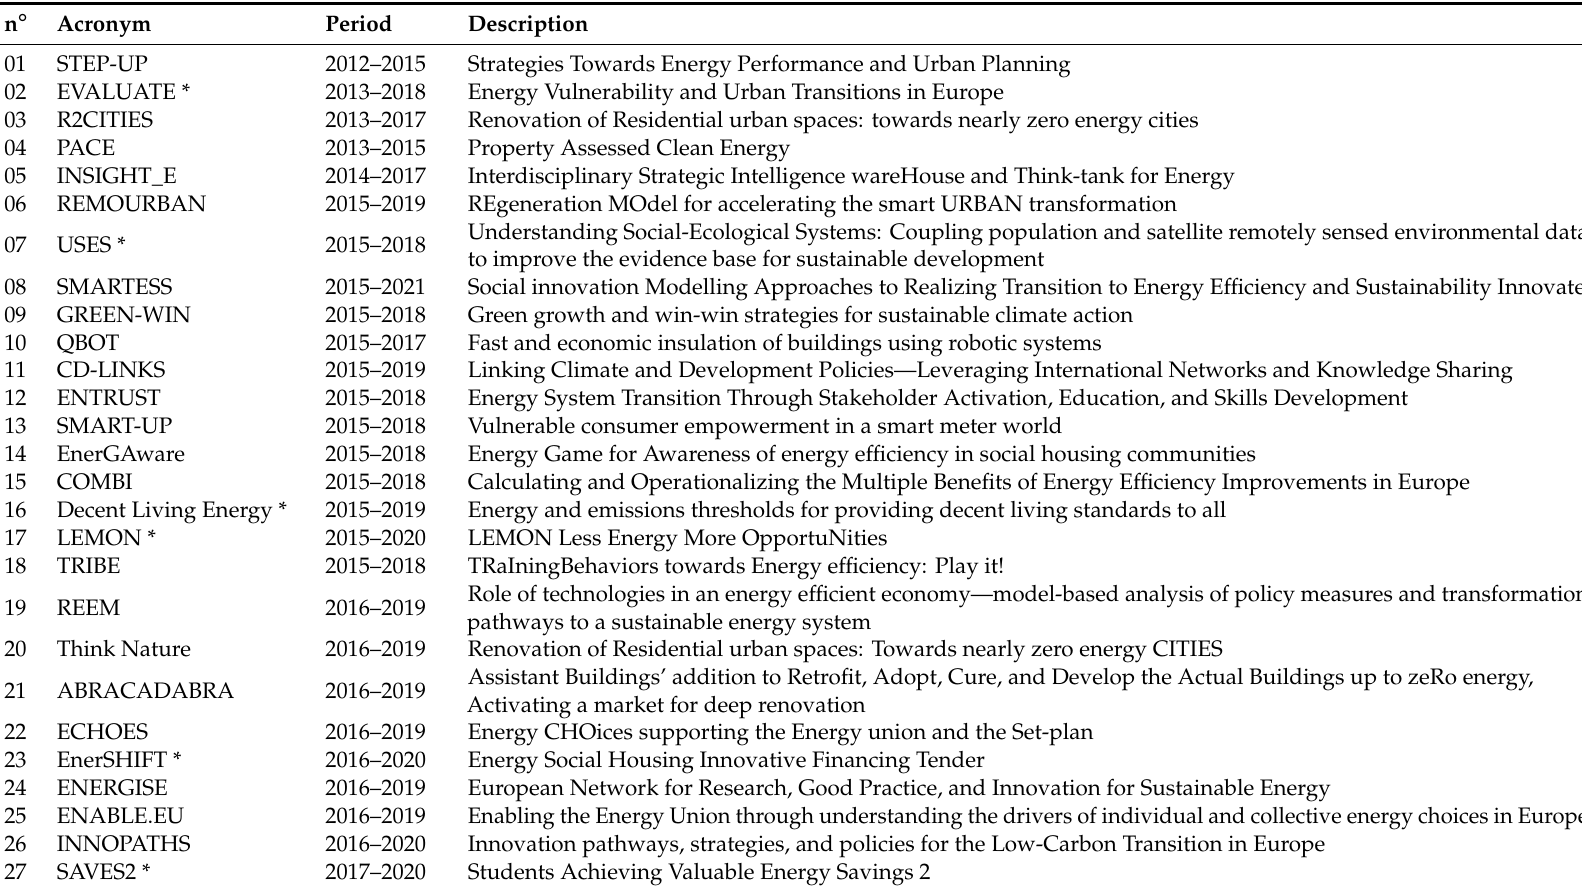
Table A1. List of FP7 and H2020 selected